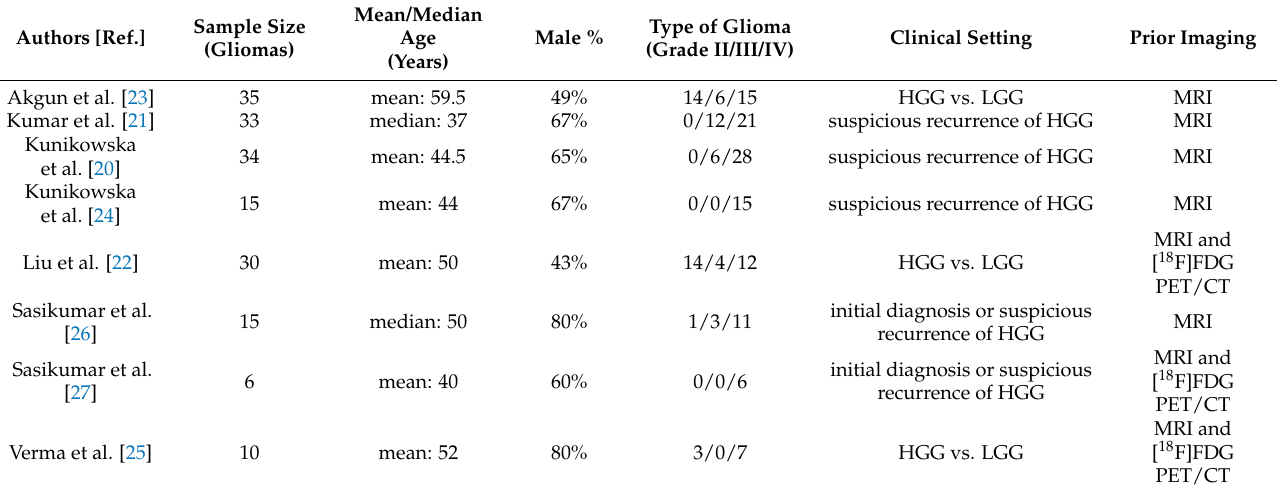
Table 2. Patient key characteristics and clinical setting.